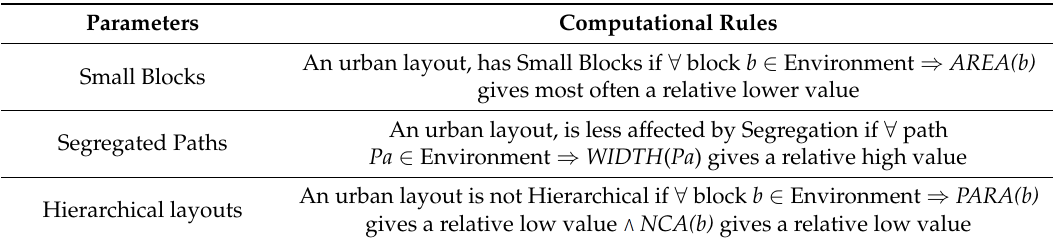
Table 7. Parameters and rules that qualify the city permeability.